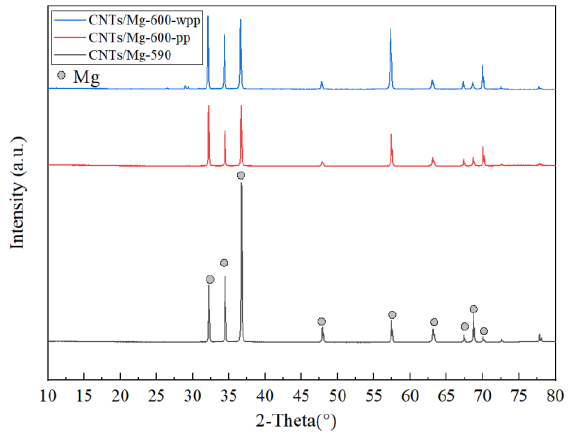
Figure 7. XRD pattern of the materials.